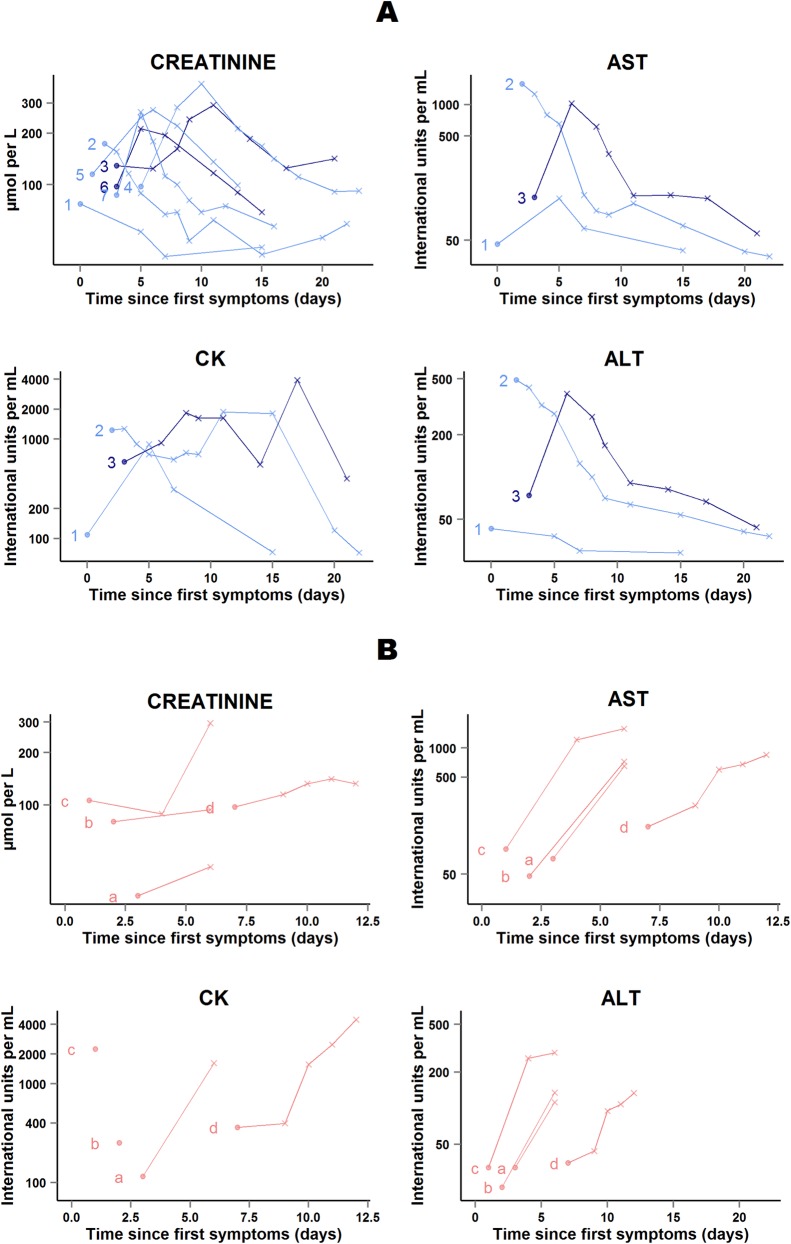
JIKI trial: evolution of serum creatinine, transaminases, and creatine phosphokinase in the 11 adolescents and adults who had worsening in at least one biochemical parameter on favipiravir.(A) Patients who survived (n = 7). (B) Patients who died (n = 4). Each line represents one patient. All patients are identified with an ID number (from 1 to 7) or letter (from a to d) throughout the figures. For all 11 patients, all available data are shown. Dots represent baseline values, and X’s represent follow-up values. Dark blue lines represent patients with baseline Ct < 20 who survived. Light blue lines represent patients with baseline Ct ≥ 20 who survived. Light red lines represent patients with baseline Ct ≥ 20 who died. The x-axis represents the time since first symptoms (for example, for a patient whose first symptom occurred 5 d before admission to the treatment center, the baseline value dot is positioned at 5 d). Samples obtained more than 25 d after onset of symptoms are not represented. All 11 patients continued favipiravir.